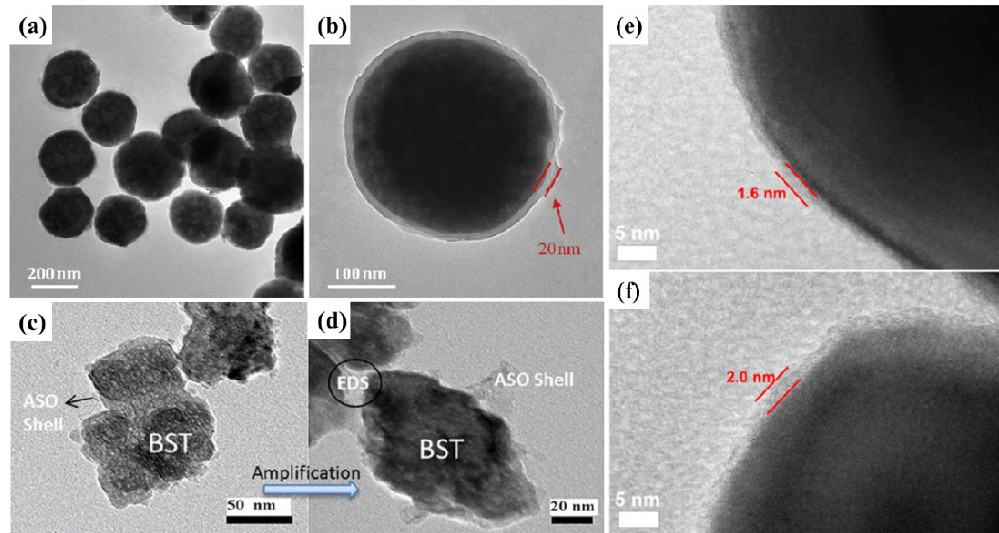
Fig. 20 FE-TEM images of (a, b) BaTiO 3 @La 2 O 3 @SiO 2 particles [112], (c, d) BST-2A1S particles [113], and (e, f) BaTiO 3 particles without and with Al 2 O 3 [40]. Reproduced with permission from Ref. [112], © Elsevier B.V. 2016; Ref. [113], © Springer Science+Business Media New York 2013; Ref. [40], © The American Ceramic Society 2017.